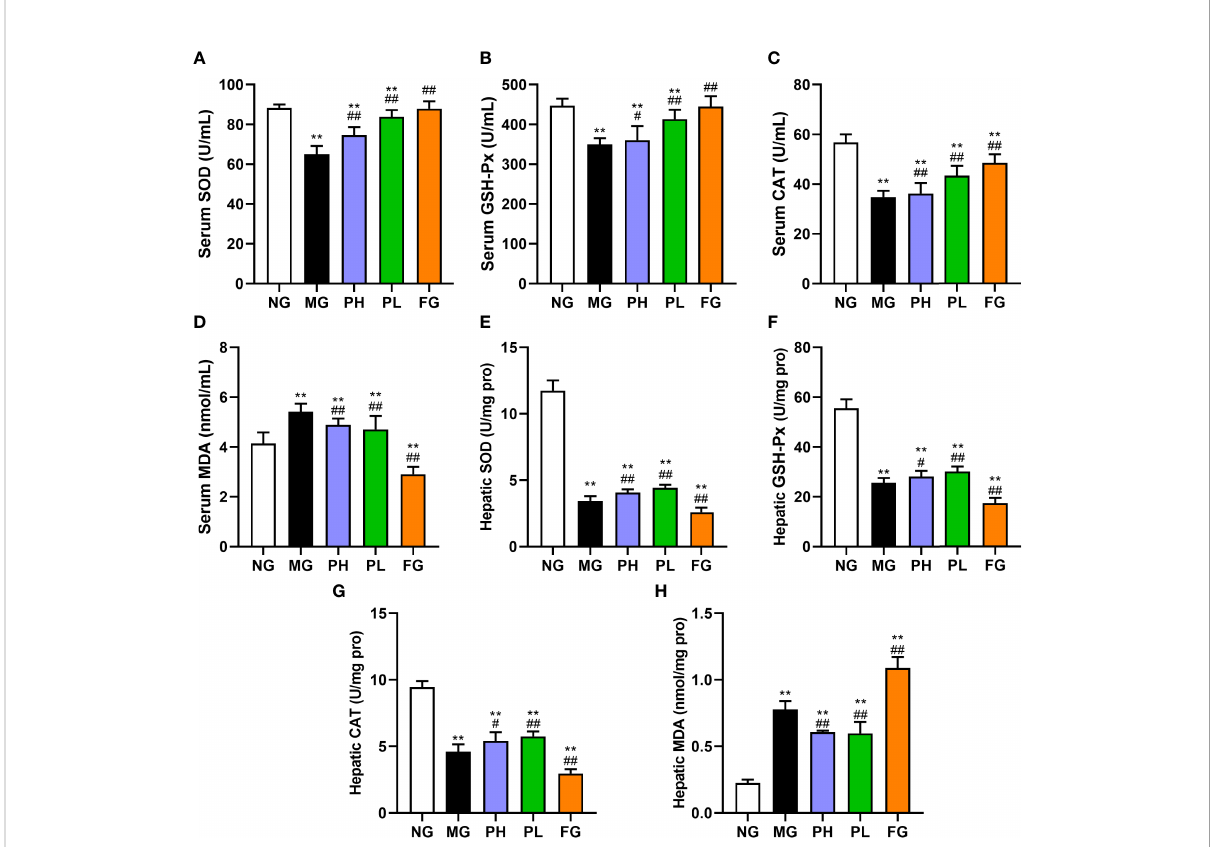
FIGURE 4 Effect of puerarin on oxidative stress. (A) Serum SOD; (B) serum GSH-Px; (C) serum CAT; (D) serum MDA; (E) hepatic SOD; (F) hepatic GSH-Px; (G) hepatic CAT; (H) hepatic MDA. Data were expressed as mean ± SD (n = 10). **p < 0.01, vs . NG; # p < 0.05, ## p < 0.01, vs .